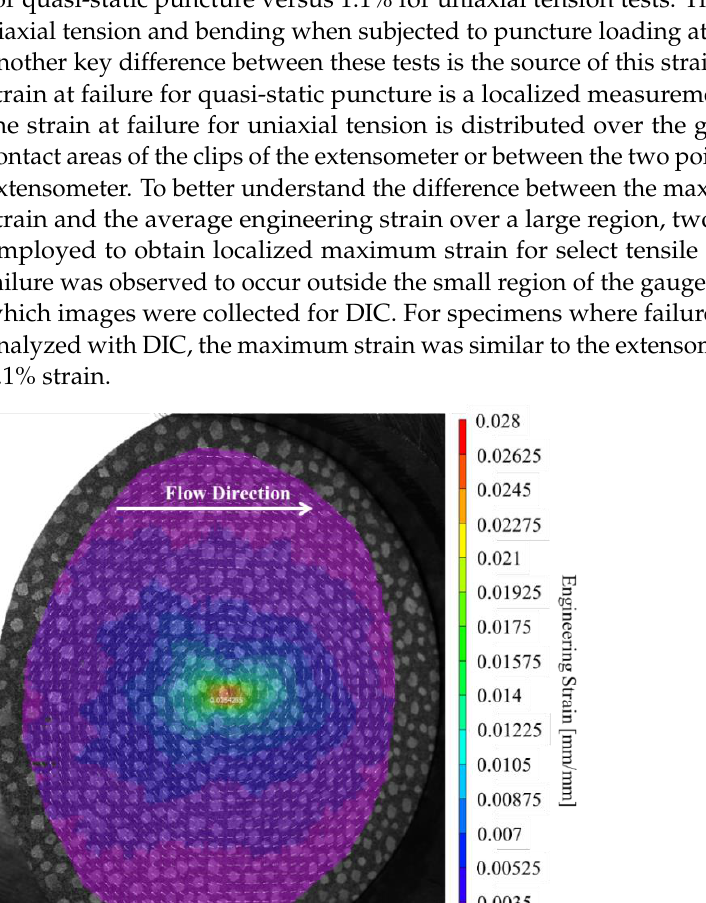
Table 5. Summary of quasi-static puncture mechanical responses.